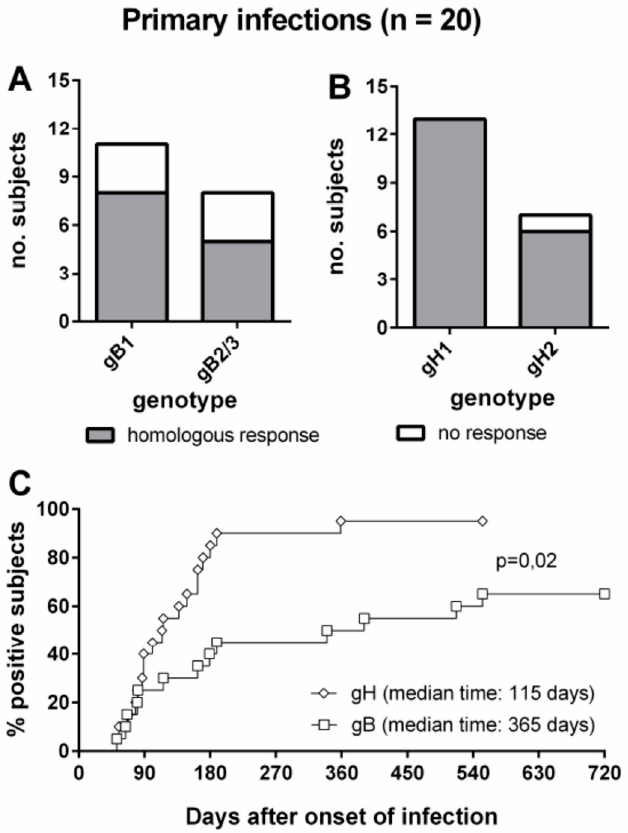
Figure 2. Genotype-specific IgG antibody to gB and gH in subjects with HCMV PI. ( A ): gB genotype- specific IgG response in subjects infected by gB1 and gB2/3 HCMV strains. ( B ): gH genotype-specific IgG response in subjects infected by gH1 and gH2 HCMV strains. ( C ): Comparative times to development of genotype-specific IgG responses to gB and gH